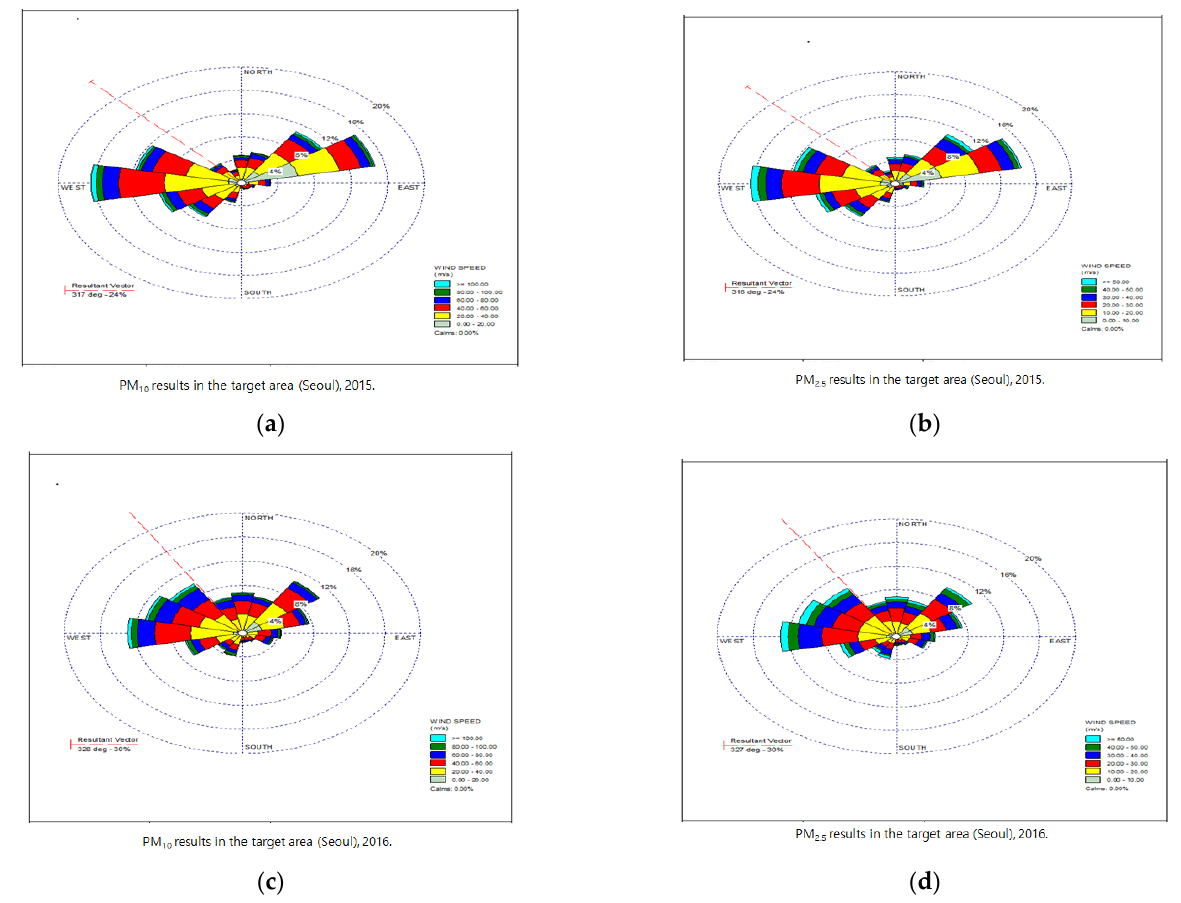
Figure 4. Correlation between the concentration (log-linear) of fine dust (PM10 and PM2.5) and the local climate (wind). ( a ) PM10 results in the target area (Seoul), 2015. ( b ) PM2.5 results in the target area (Seoul), 2015. ( c ) PM10 results in the target area (Seoul), 2016. ( d ) PM2.5 results in the target area (Seoul), 2016.